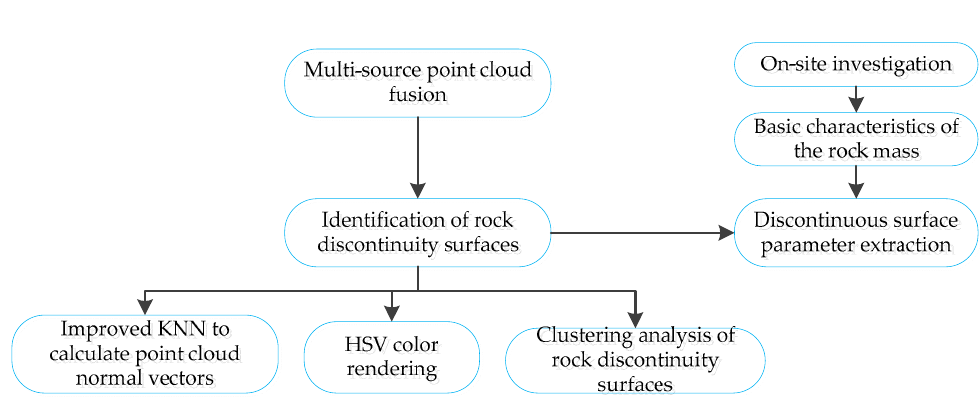
Figure 11. Intelligent identification flow chart of rock discontinuity.